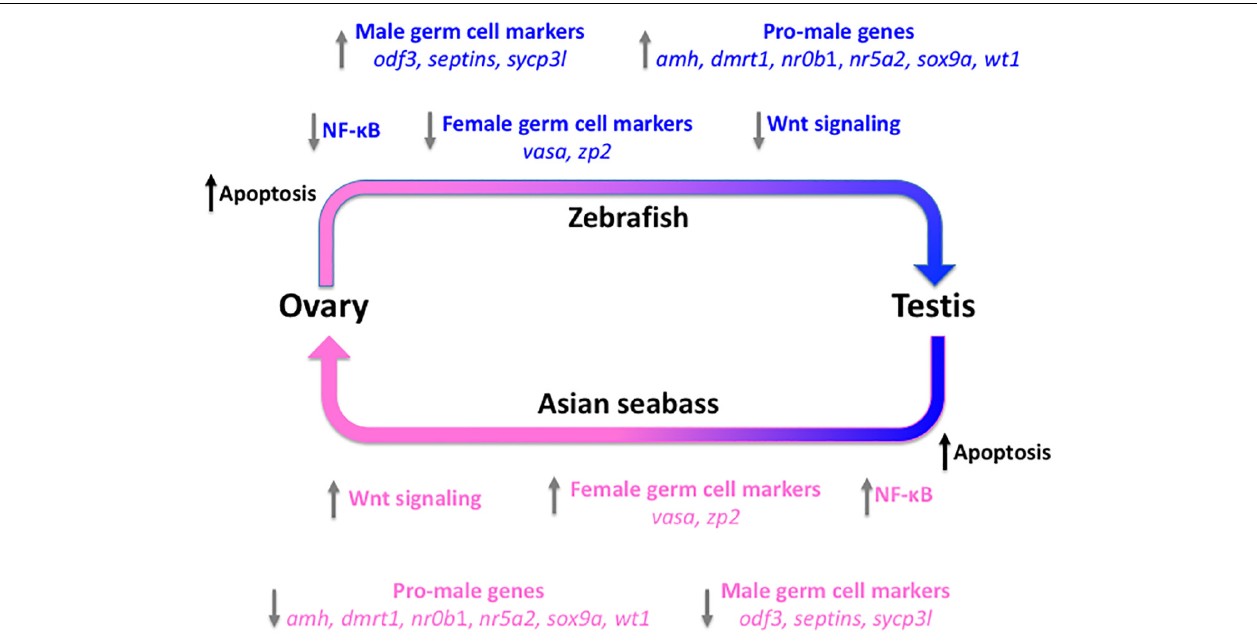
FIGURE 3 | Molecular events during gonad transformation in teleosts using the zebrafish and the protandrous Asian seabass as models. All immature zebrafish develop a “juvenile ovary” before the future males undergo gonadal transformation to form the testis. Several pathways and genes have been shown to be involved in this process. We propose that many of these are also involved in the testis-to-ovary transformation of Asian seabass, despite the direction being the opposite. The arrows show the observed (zebrafish; top – blue) and/or predicted and later partially confirmed (Asian seabass; bottom – pink) differentially regulated genes or pathways during the gonadal transformation process. Apopotosis (black) is the first pathway activated at the beginning of the transformation in both systems to eliminate cells that cannot be trans-differentiated, independently from the direction. The trigger is unknown in both cases [improved Figure 6 of Ravi et al. (2014) with the authors’